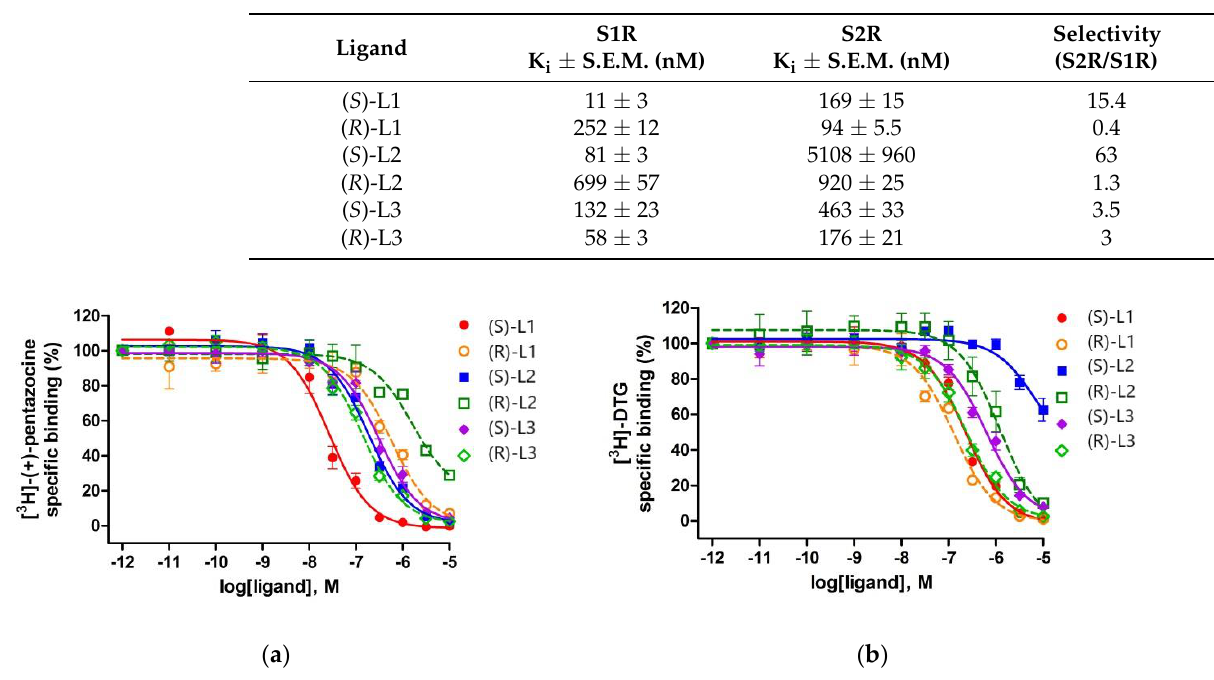
Figure 4. Displacement curves for corresponding ligands against ( a ) [ 3 H]-(+)-pentazocine binding to S1R sites in guinea pig liver membranes and ( b ) [ 3 H]-DTG binding to S2R sites in rat liver brain membranes using (+)-pentazocine (100 nM) to mask S1R sites. Data are mean percentage of specific binding ± SEM from minimum three independent experiments, each performed in duplicate.